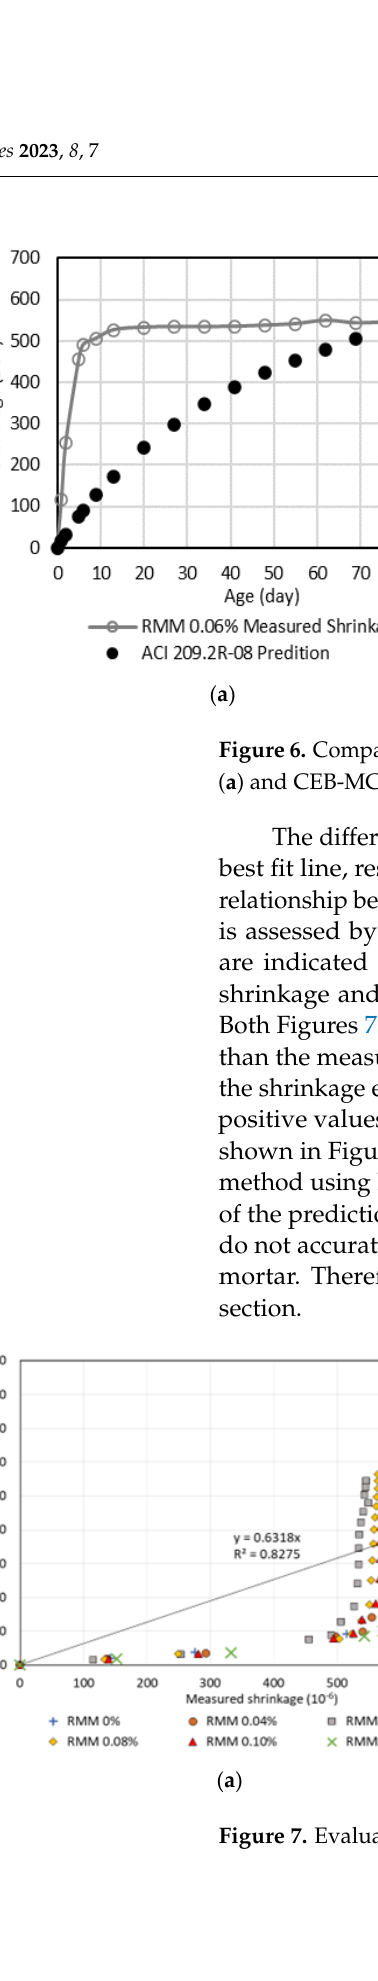
( b ) Figure 8. Evaluation of the ACI 209.2R-08 ( a ) and CEB-MC 90-99 ( b ) models by residual analysis. Table 3. Summary of quantitative evaluation of shrinkage prediction models. Method